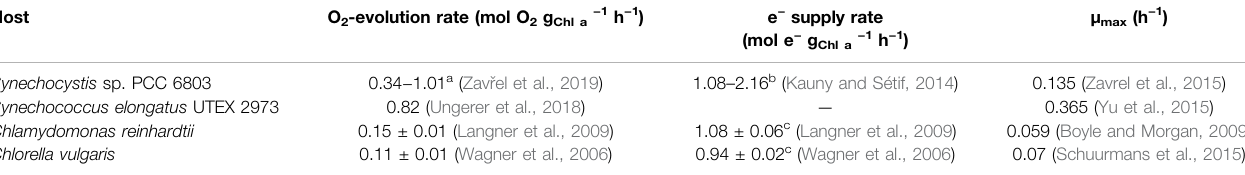
TABLE 3 | Photosynthetic rates of phototrophic host organisms applied for redox biocatalysis.